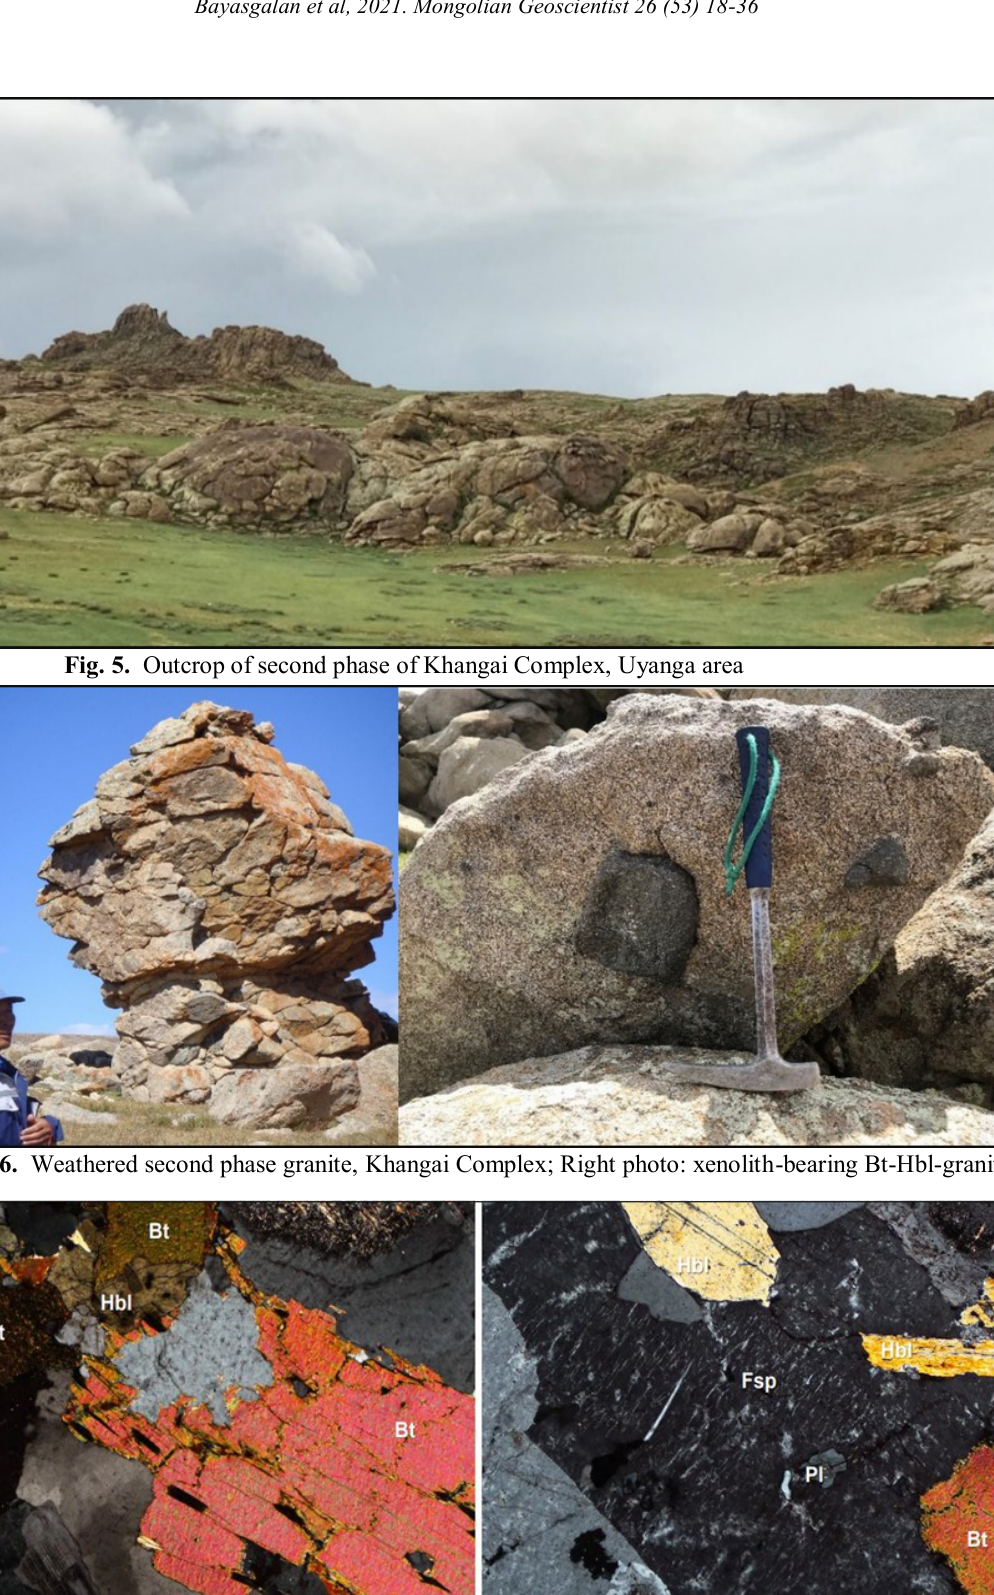
Fig. 7. Microphotograph of the second phase granodiorite, Taatsiin Gol pluton Khangai Complex (Si-41) Hbl-hornblend, Bt-biotite, Pl-plagioclase, Fsp- K - feldspar,